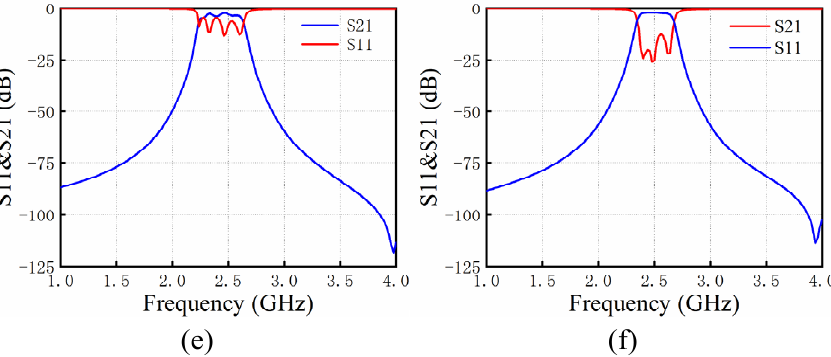
Figure 6. ( a ) Initial response of the filter. ( b ) Response after the first iteration. ( c ) Response after the second iteration. ( d ) Response after the fourth iteration. ( e ) Response after the fifth iteration. ( f ) Response after the sixth iteration.